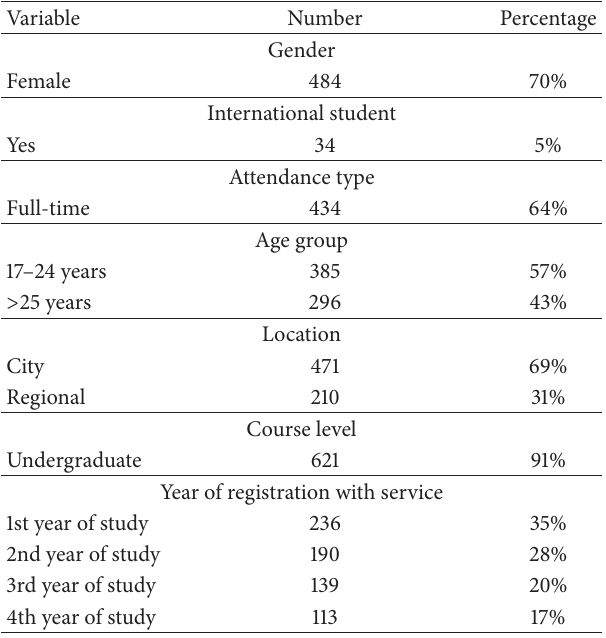
Table 1: Demographic profile of the 681 students with mental illness who registered with the University’s Disability Support Service.